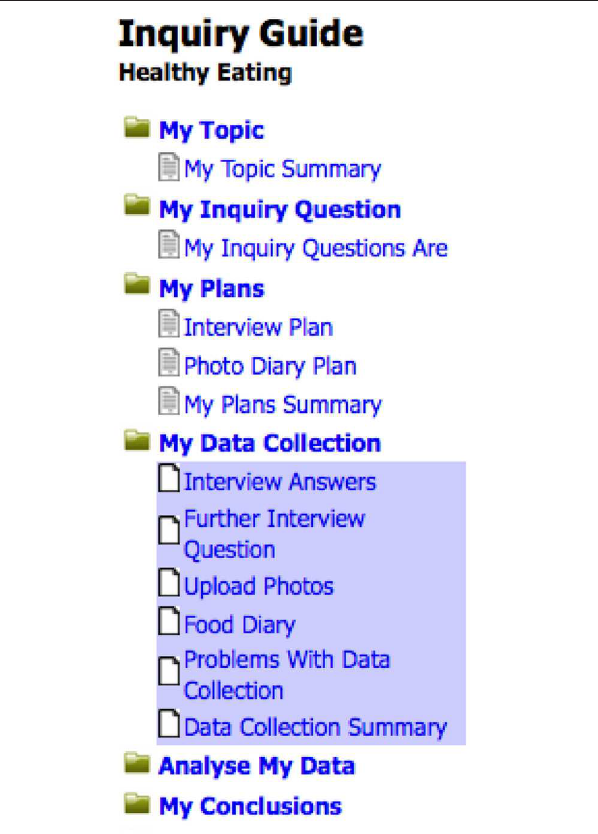
different meanings of the “scenario” term were surfaced early